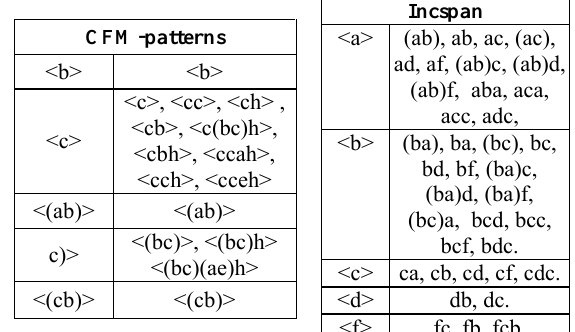
Table 5. Comparison of algorithms in mining